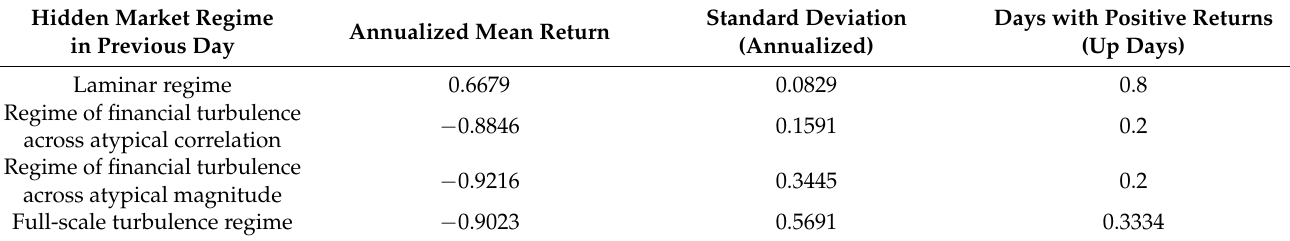
Table 16. Daily returns distribution for the RTSI index during switches among four Markov regimes in the COVID-19 crisis. Hidden Market Regime in Previous Day